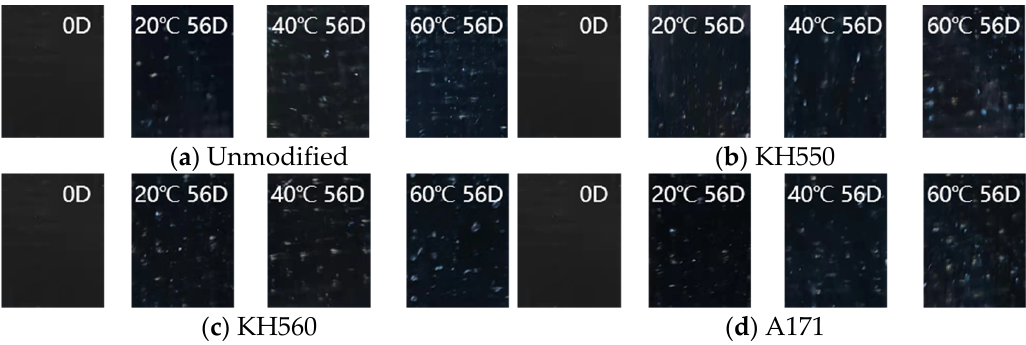
Figure 9. Appearance changes in a high-concentration seawater environment.